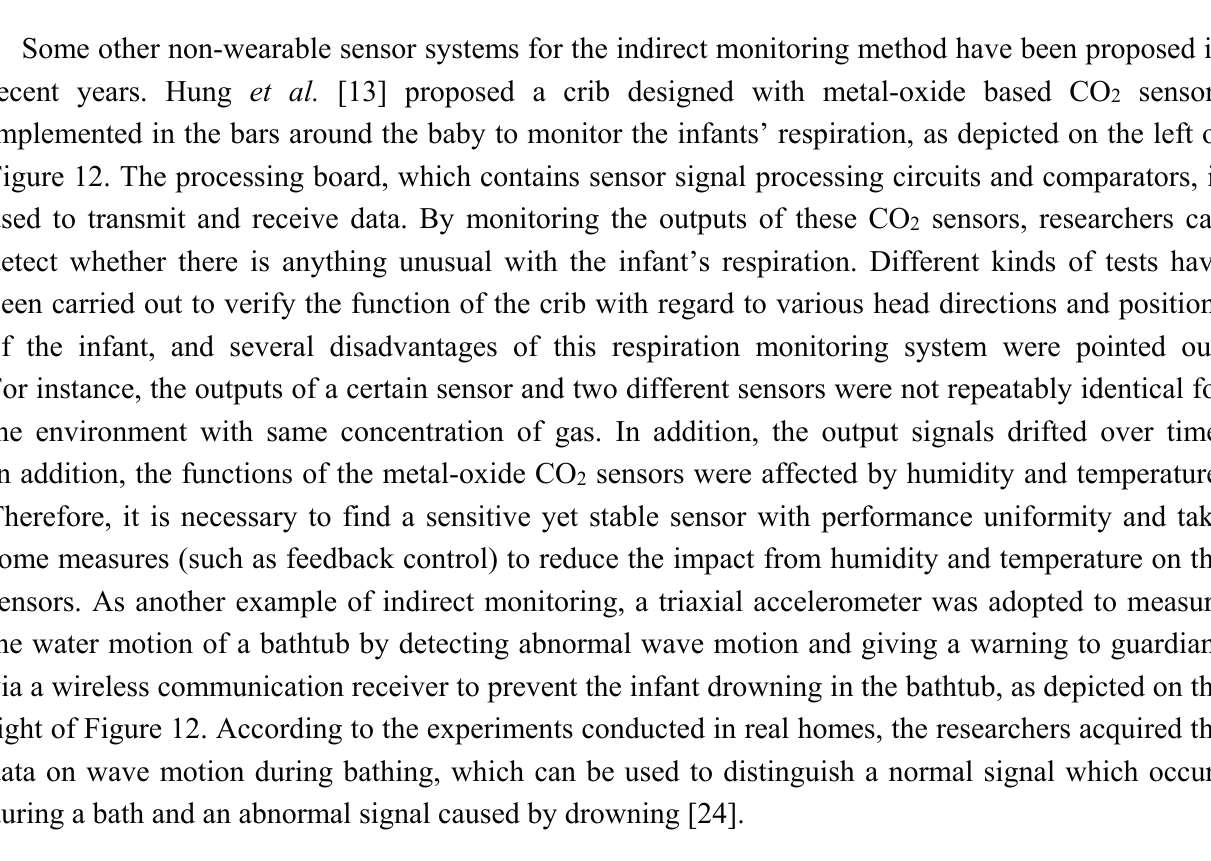
Figure 11. SleepSafe infant monitor [23]. Copyright © 2007